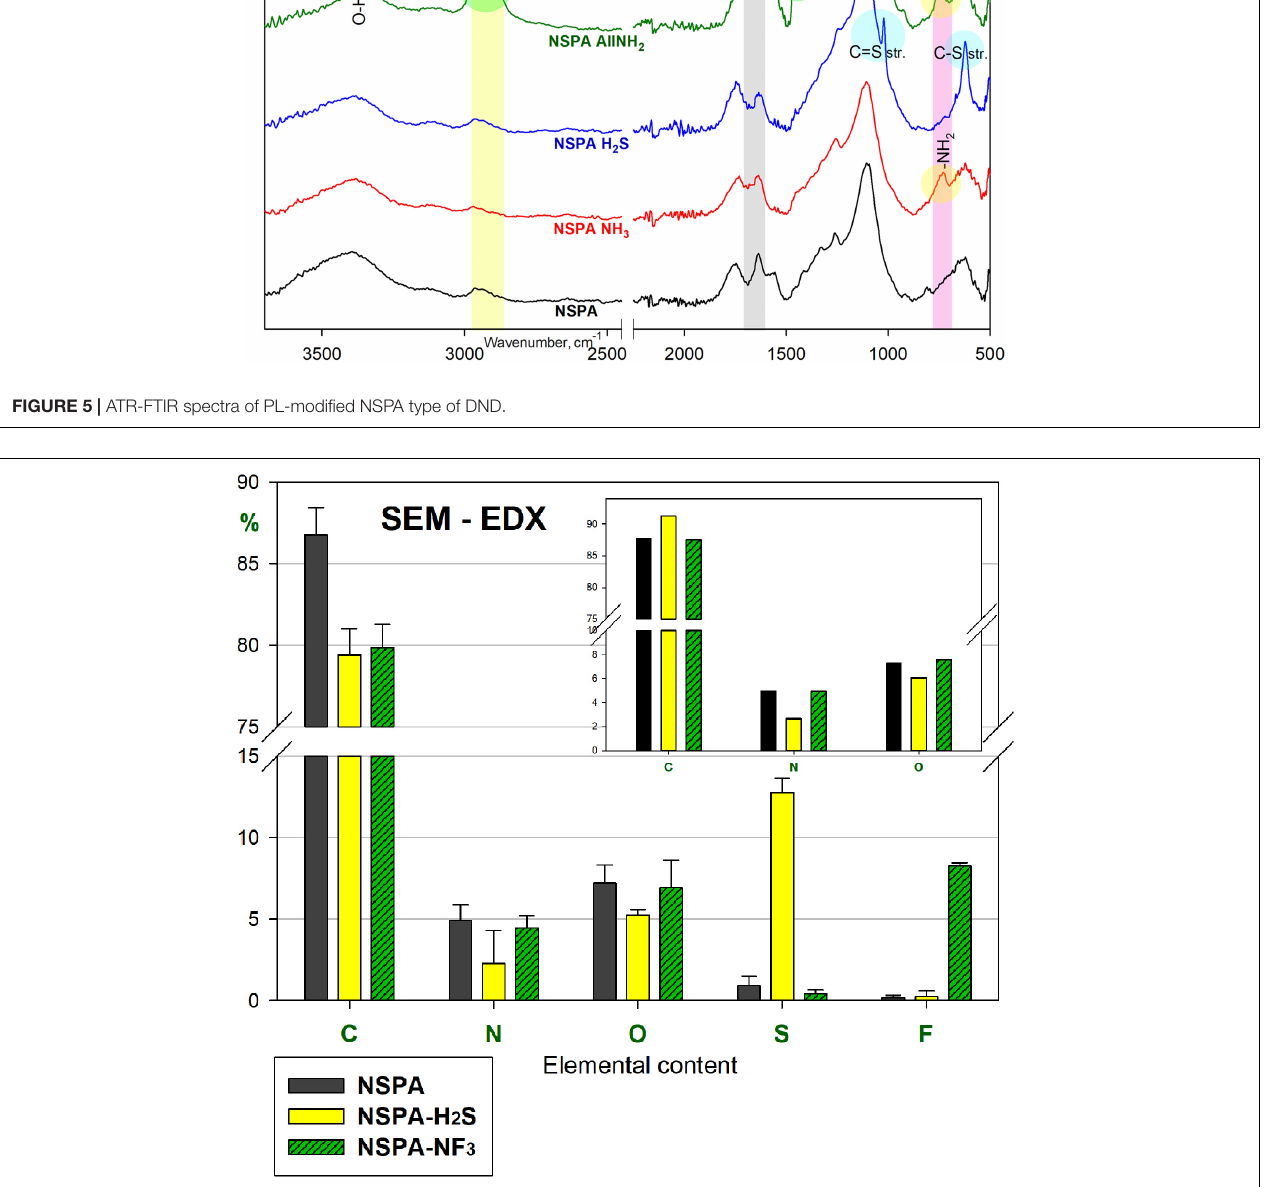
FIGURE 6 | SEM-EDX elemental content of PL-sulphhydrylated and fluorinated samples, as compared with parent NSPA (“CNO-only” comparison: the inset plot at top right).